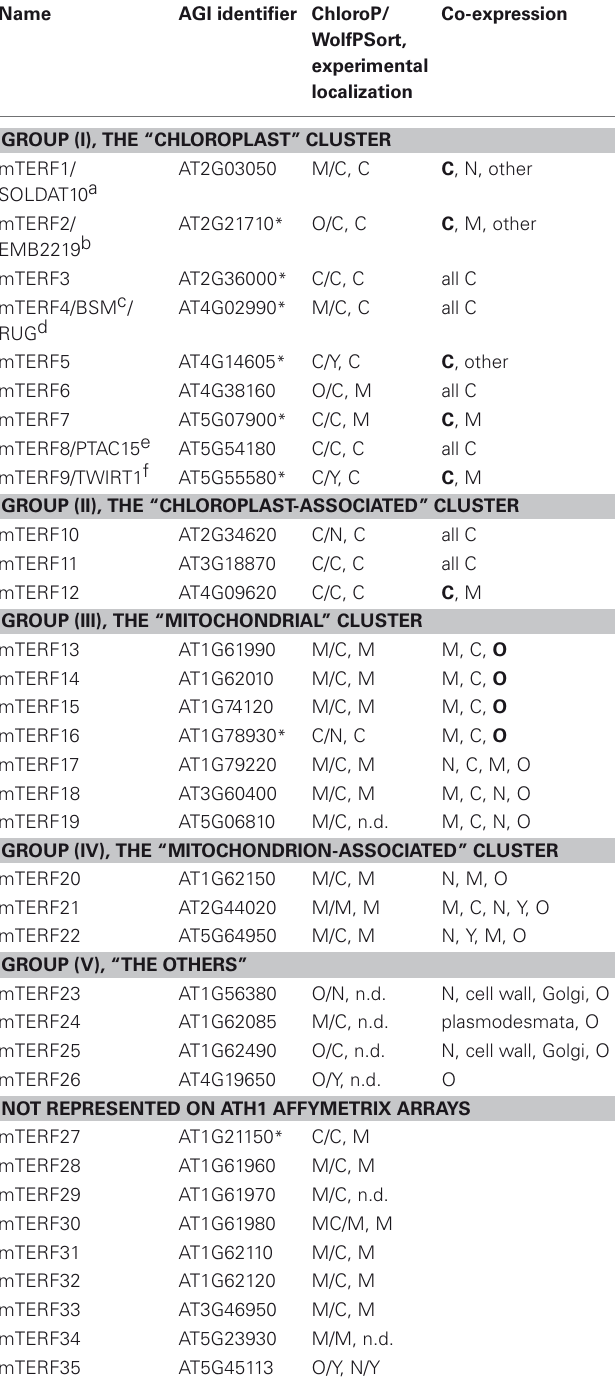
Table 1 | Overview of the different groups of mTERF